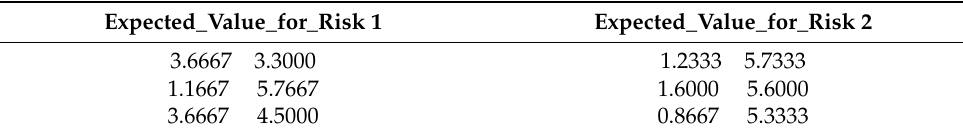
Table 10. Expected value for risks for the first risk.